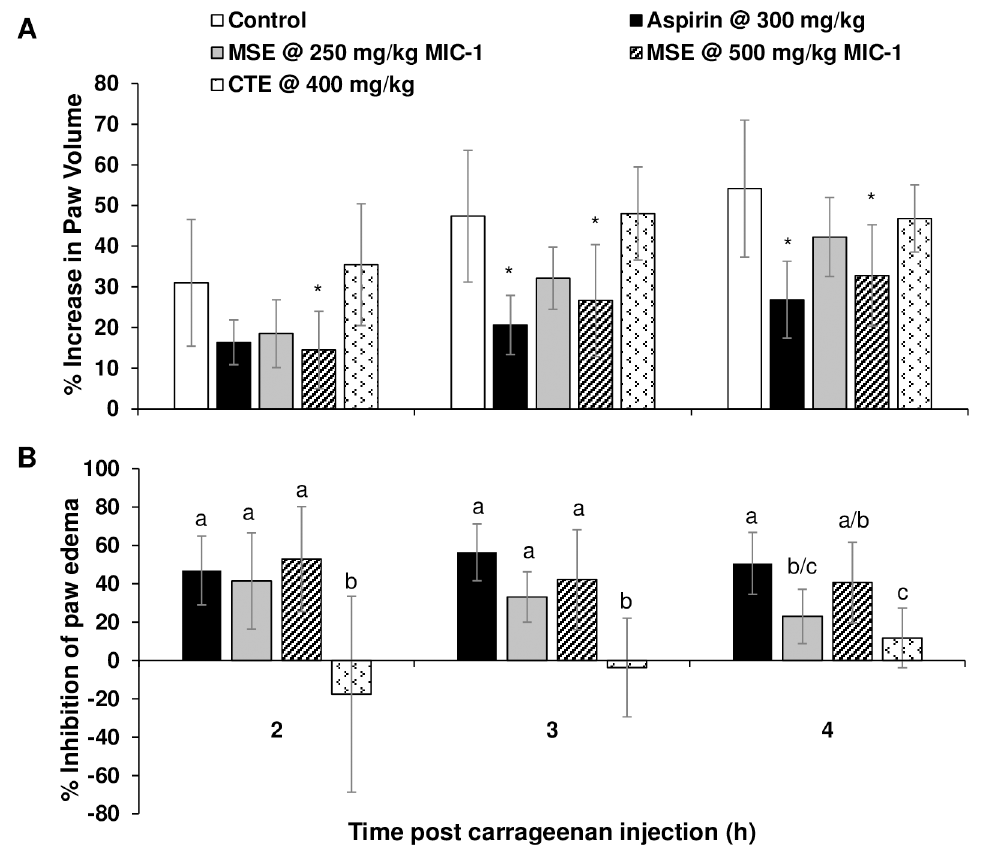
Fig 4. Inflammatory response in the hind-paw of rats treated with MSE and CTE prior to injection with carrageenan. A) Percent increasein paw volume. Statistical analysiswas performed by one-wayANOVA followedby Dunnett’s post-hoc test. Bars showingan asterisk indicatesignificantdifference from the vehicle control ( p < 0.05). B) Percent inhibitionof paw edema. Statistical analysiswas performed by one-wayANOVA followedby Tukey’s post-hoc test. Significance is indicatedby different letters ( p < 0.05). Data are the mean ± SD (n =